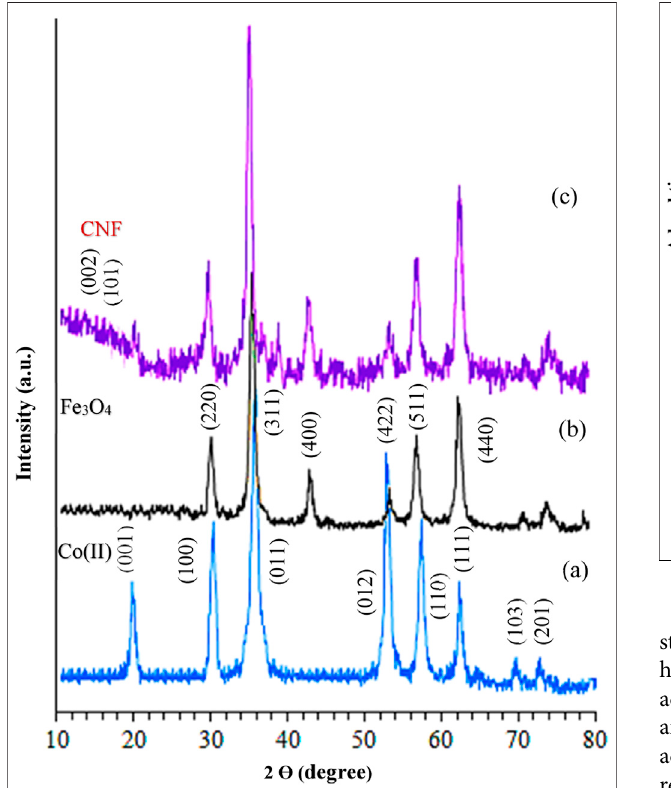
FIGURE 8 | UV-Vis spectra of Co(OAc) 2 , Fe 3 O 4 , Fe 3 O 4 @CNF, and Fe 3 O 4 @CNF ∼ ImSBL ∼ Co. in H 2 O